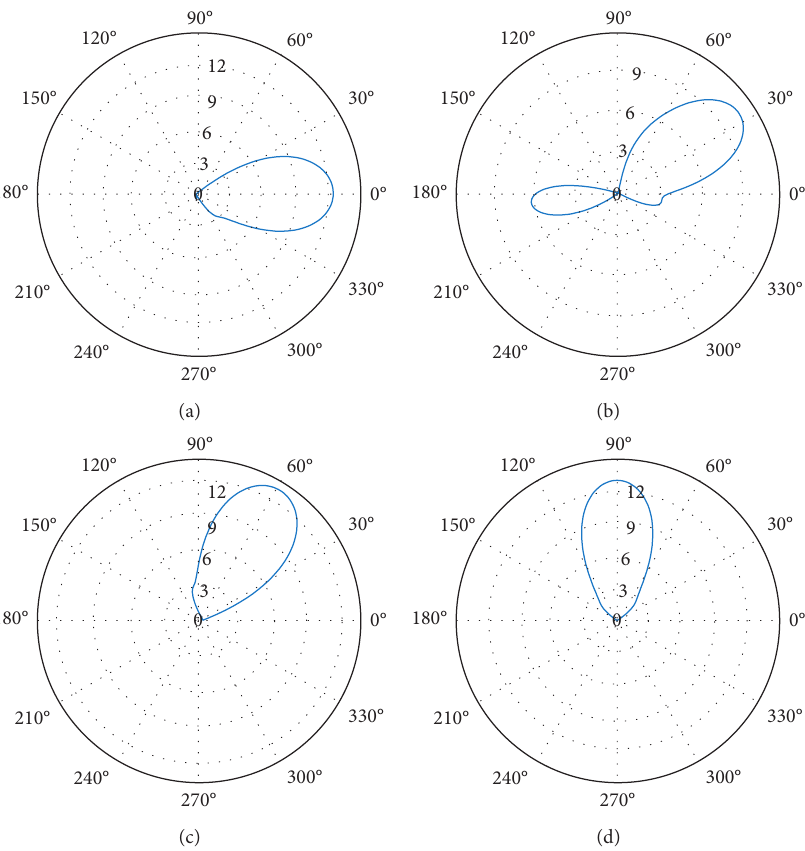
Figure 10: Radiation diagrams using PSO: (a) 0 ° –12.68dBi, (b) 30 ° –10.13 dBi, (c) 60 ° –12.76 dBi, and (d) 90 ° –13.31dBi.